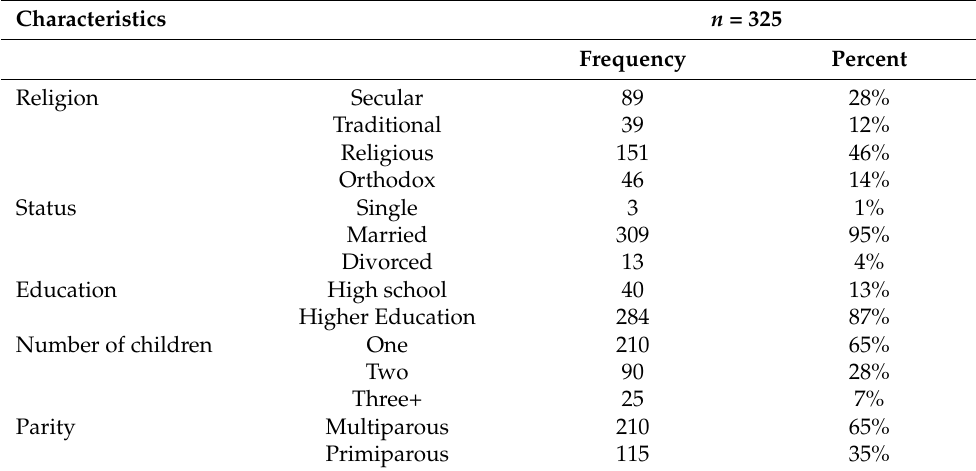
Table 1. Background characteristics of